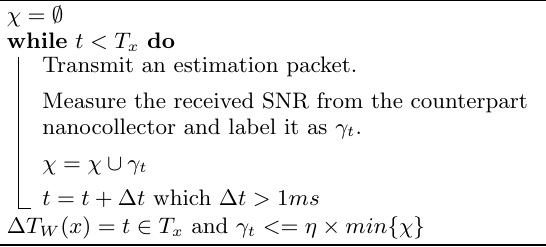
Algorithm 1: Wake-up intervals